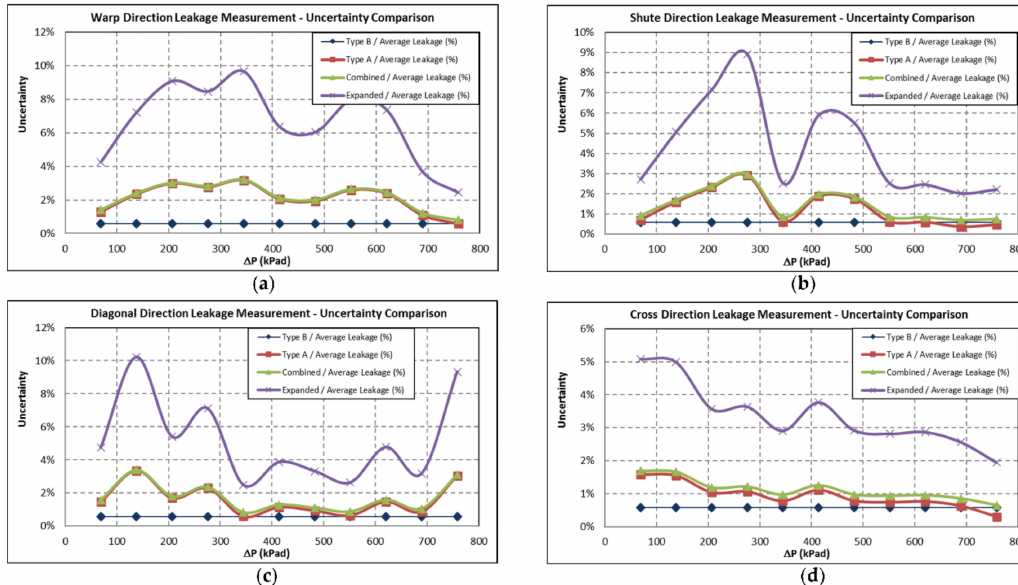
Figure A1. Uncertainty analyses for metallic-cloth fiber leakage tests: ( a ) warp direction, ( b ) shute direction, ( c ) diagonal direction, and ( d ) cross